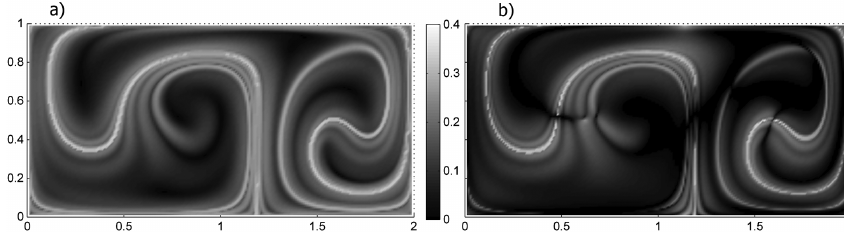
Figure 3. Forward FTLE field of a periodic double-gyre velocity field. (a) The benchmark FTLE field at t 0 = 1 calculated by Eq. (6). (b) The approximated FTLE field calculated by Eq. (8), and δt = 0.2 time units. A fourth-order Runge–Kutta integration scheme with constant integration time step 0.01 and total integration time T = 15 time units is implemented for both